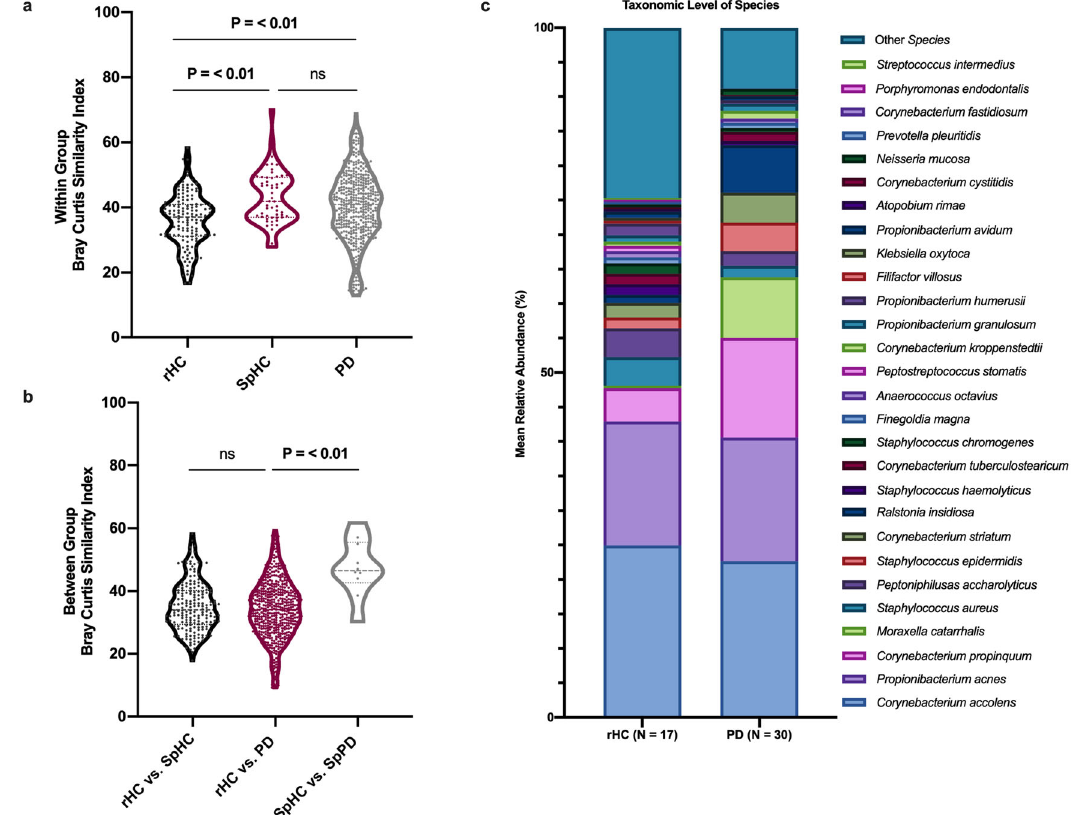
Fig. 1 Deep nasal microbial communities in PD and control subjects. a Differences in overall microbial pro fi les (taxonomic level of species) measured using within group Bray – Curtis similarity index between random HC (rHC; n = 17), Spousal HC (SpHC; n = 11) and PD ( n = 30; One- Way ANOVA). b Overall distribution of between group Bray – Curtis indices between rHC ( n = 17) vs SpHC ( n = 11); rHC ( n = 17) vs. PD ( n = 30); and SpHC ( n = 11) vs. SpPD ( n = 11; One-way ANOVA). Signi fi cant p -values ( P < 0.05) bold. Each dot indicates a comparison of one pair of samples. c Average species-level relative abundance pro fi les of deep nasal microbiota of rHC ( n = 17) and PD ( n = 30). Taxa with greater than 1% relative abundance are